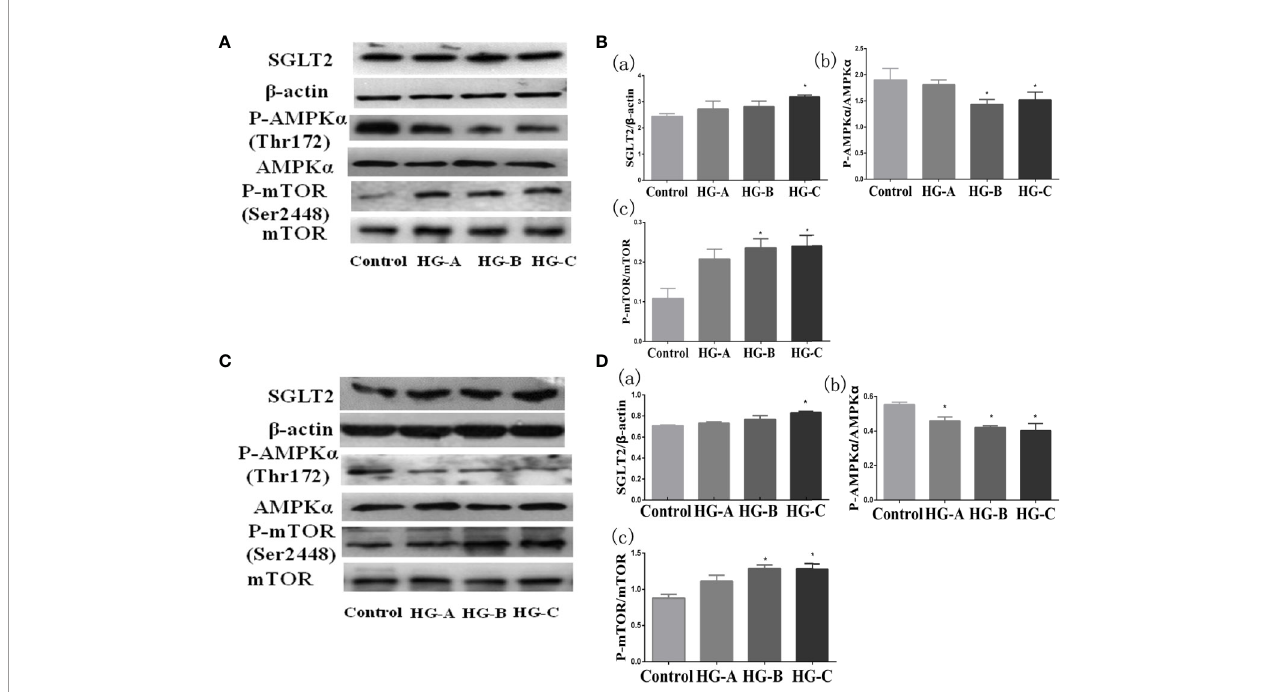
FIGURE 6 | SGLT2/AMPK/mTOR pathway changes under acute hyperglycemic state both in vivo (A, B) and in vitro (C, D) . Values are expressed as means ± SD in each group. * P < 0.05 vs. Control. Control, control group; HG-A, hyperglycemia group A; HG-B, hyperglycemia group B; HG-C, hyperglycemia group C. SGLT2, sodium glucose co-transporter 2; AMPK, 5 ’ -AMP-activated protein kinase; mTOR, mammalian target of rapamycin